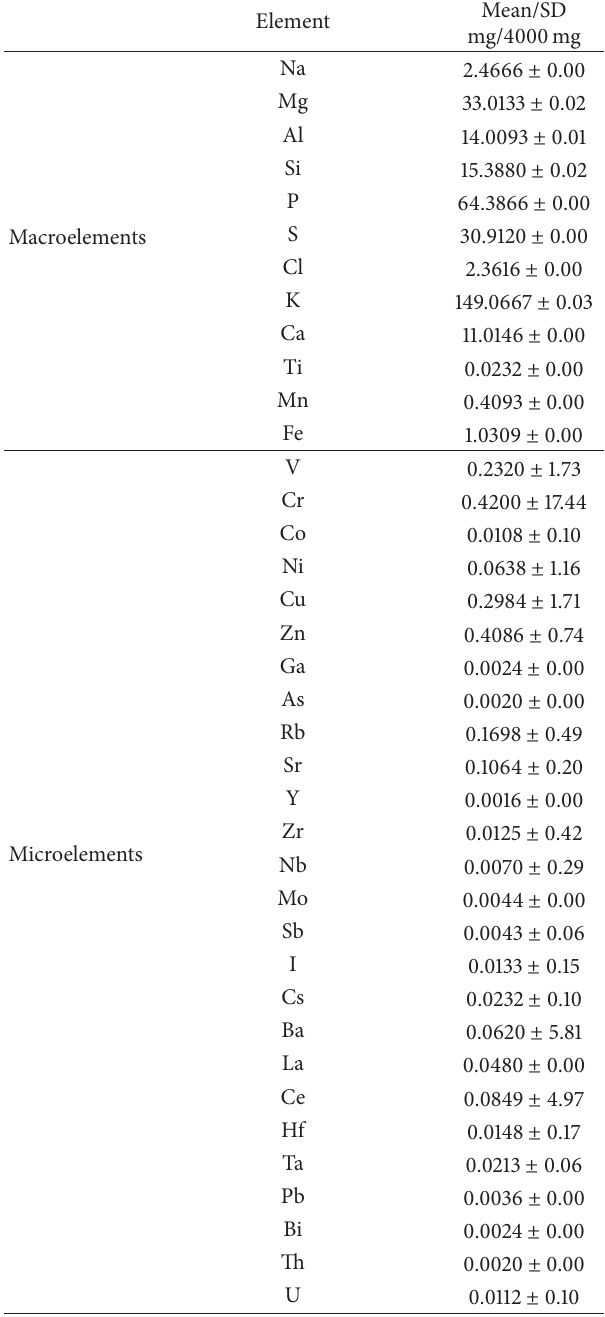
Table 1: Mean and standard deviation (SD) of measured elements (mg/4000